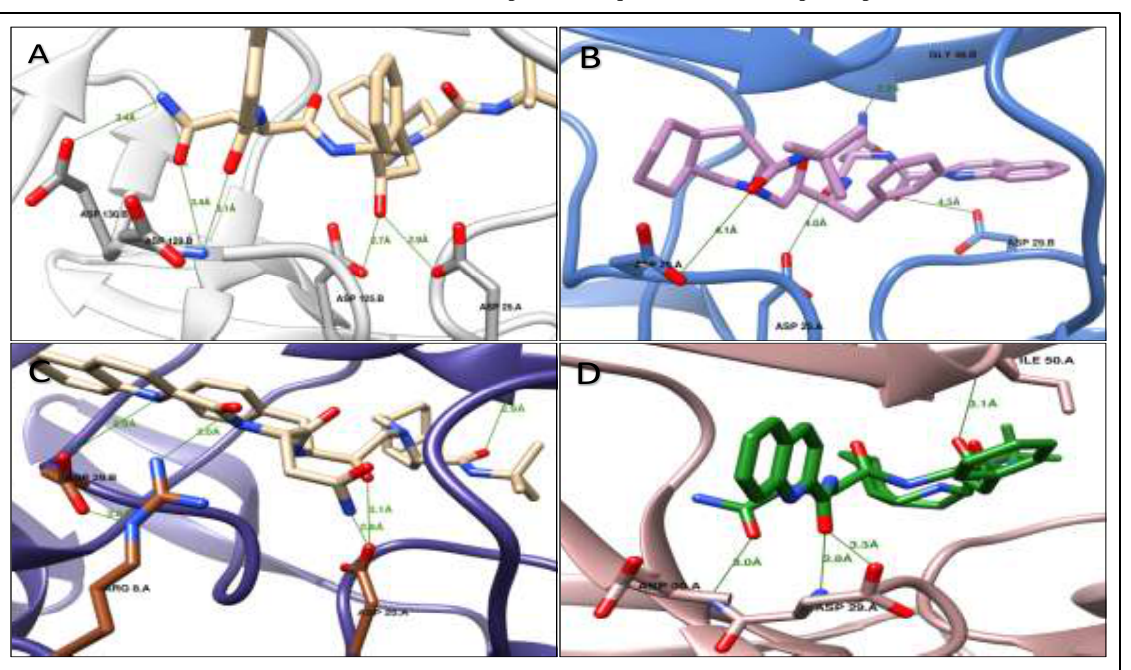
Figure 4. Binding interactions between Saquinavir and HIV-1 protease in the crystal structure and the top- scored docking solutions. A) X-ray crystal structure of Saquinavir-HIV-1 protease, B) AutoDock Vina top- score docking solution, B) 1-Click Docking top-score docking solution, D) UCSF DOCK6 top-score docking solution